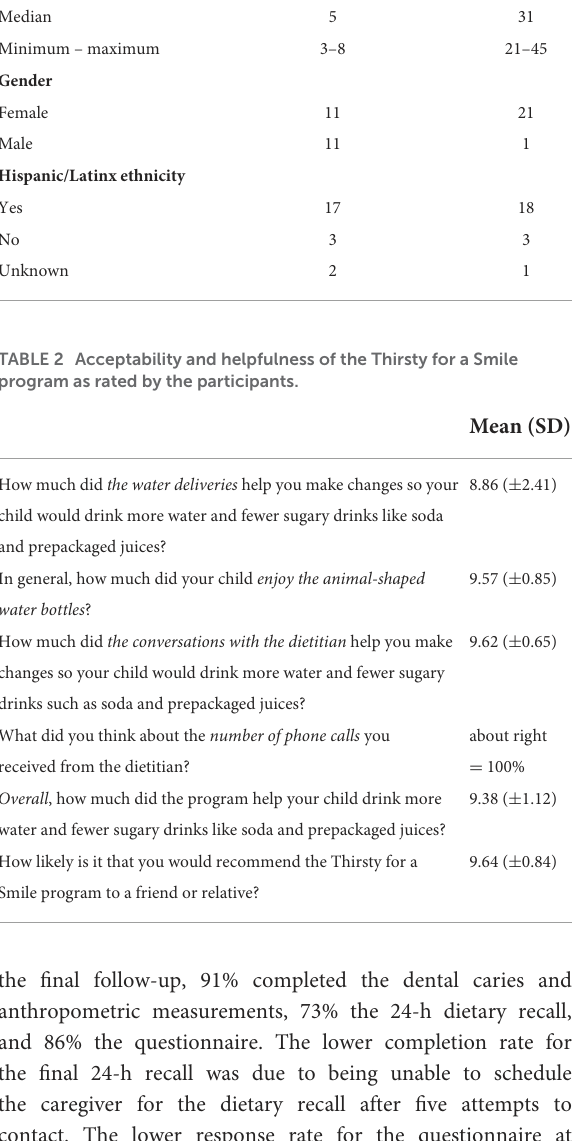
Child Caregiver